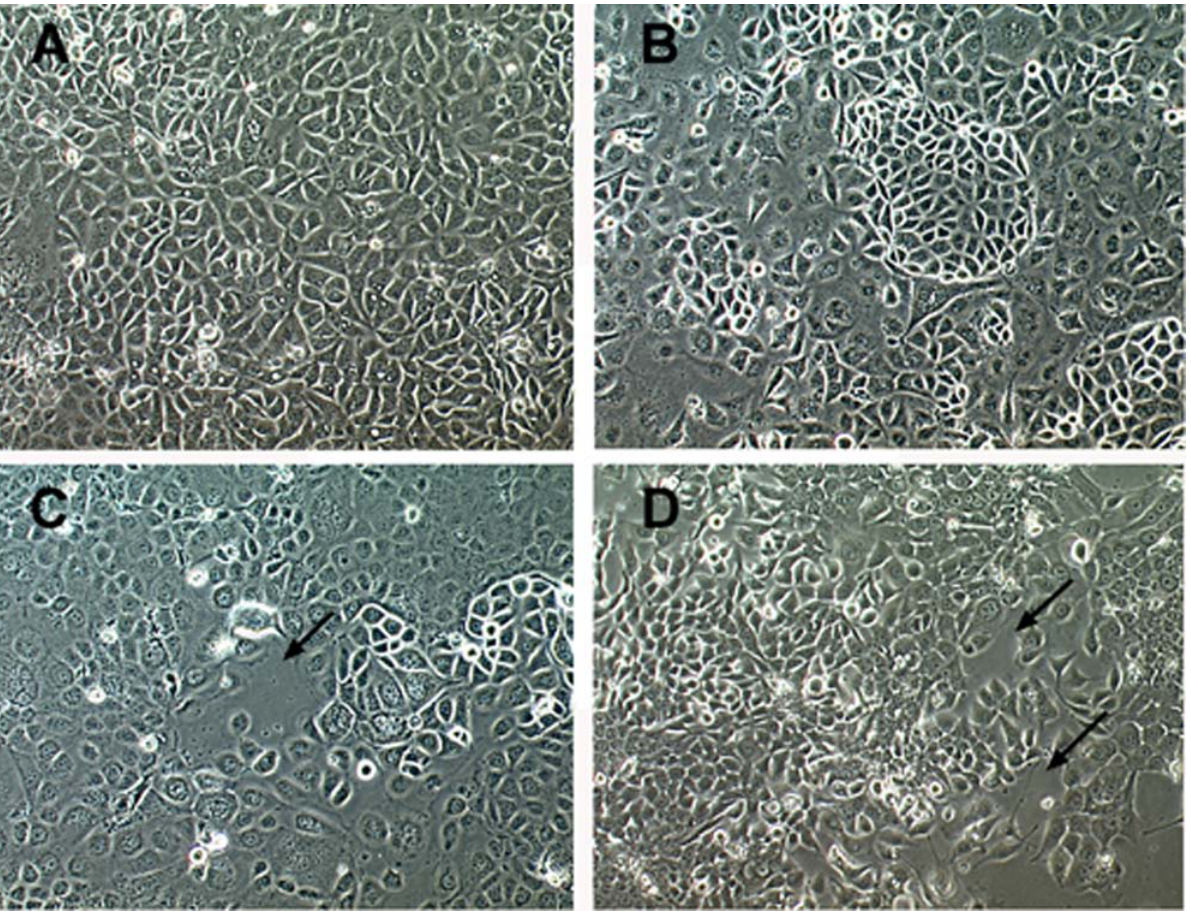
Figure 4. Phase contrast of transfected human corneal epithelial (HCE) cells. Non-transfected parental cells (panel A) form confluent epithelial sheets, as do HCE cells transfected with WT Bves (panel B). However, in WT Bves transfected cells, areas of tight adherence are readily observed (arrow head). In HCE cells transfected with mutant Bves, a contiguous monolayer is rarely formed. KK-Mut Bves transfected cells are more rounded and moderate gaps are viewed (panel C, arrows), while KK-Del transfected cells display distinct gaps.